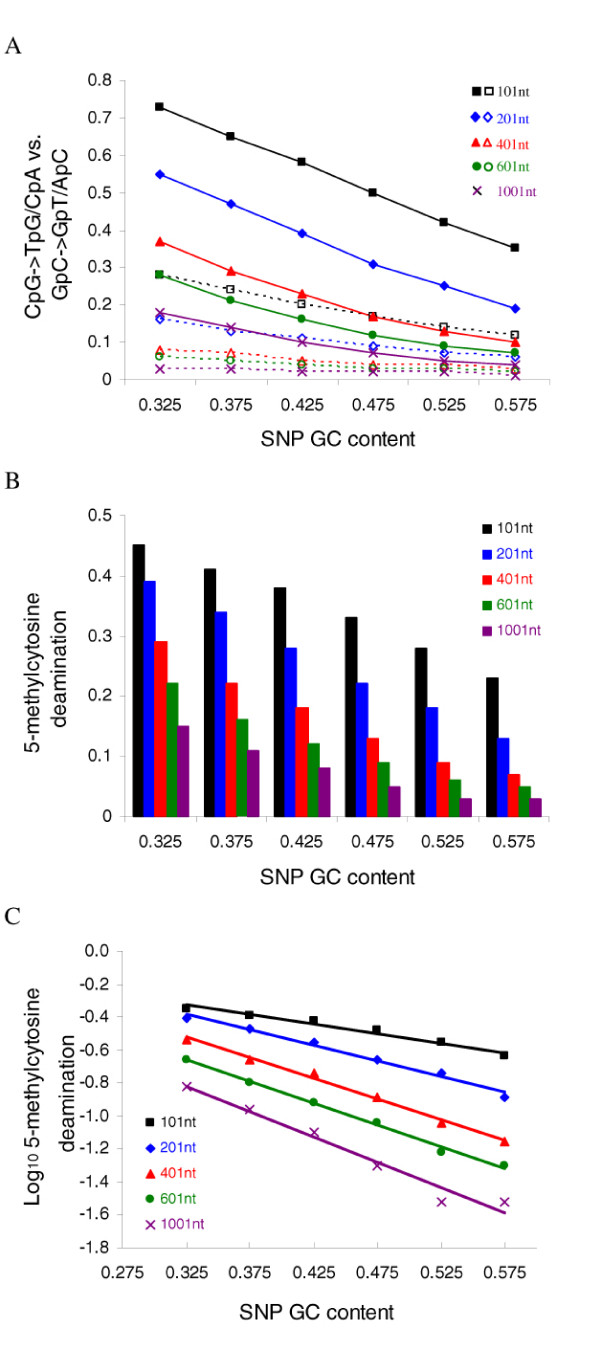
Rates of CpG transition, GpC transition, and 5mC deamination varied with local GC content and SNP sequence length. (A) Rates of CpG→TpG/CpA per CpG dinucleotide (solid line) and GpC→GpT/ApC per GpC dinucleotide (dashed line) in the SNP flanking sequences. SNP GC content was calculated from the SNP flanking sequences. (B) 5mC deamination rates, measured by the difference between the rates of CpG transition and GpC transition in A. (C) Plot of log10(5mC deamination rate) versus SNP GC content.